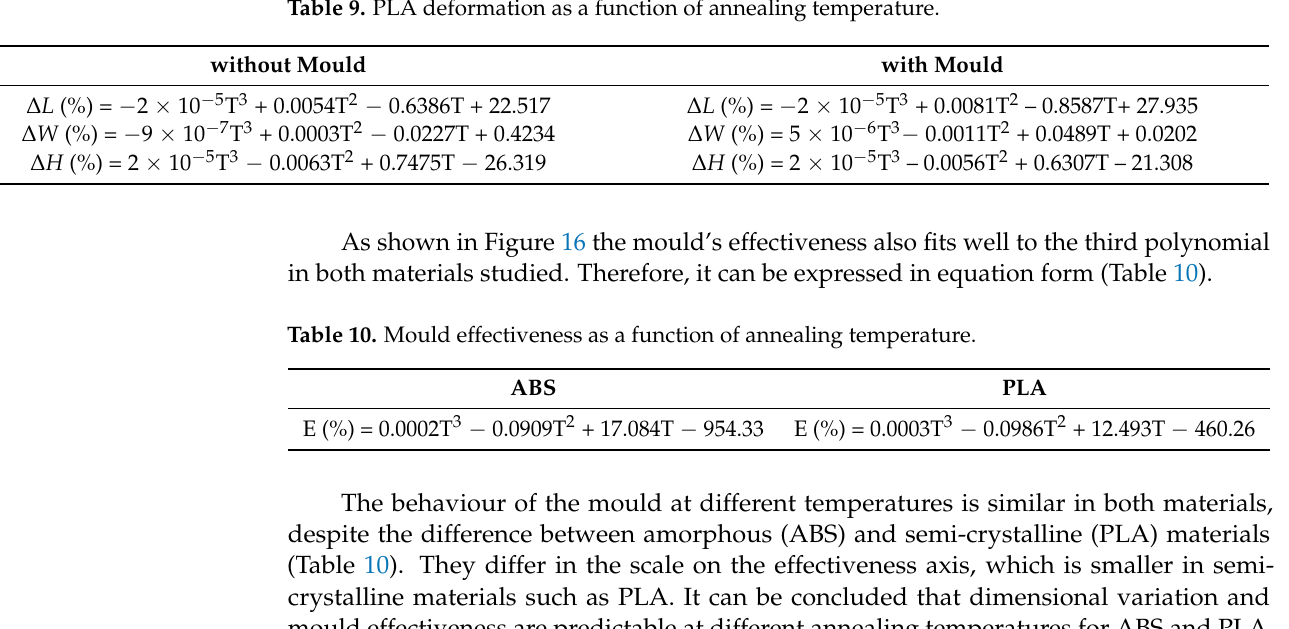
Table 9. PLA deformation as a function of annealing temperature.